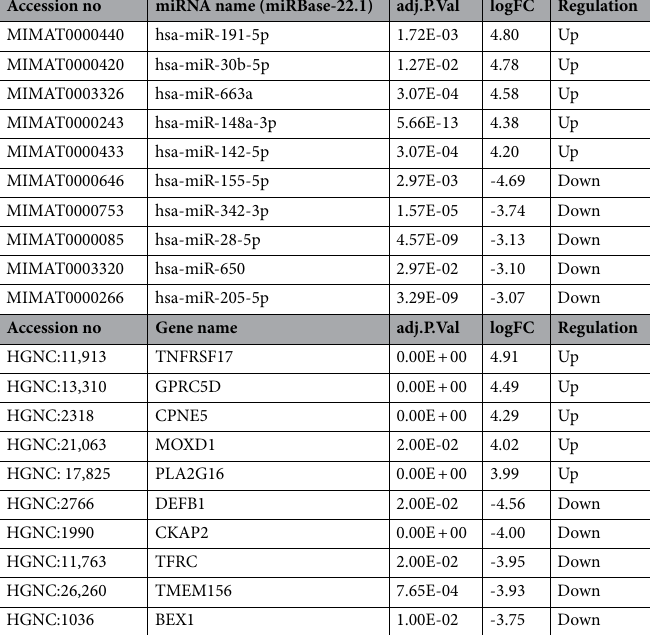
Table 1. List of top 5 up- and down-regulated miRNAs and genes in multiple